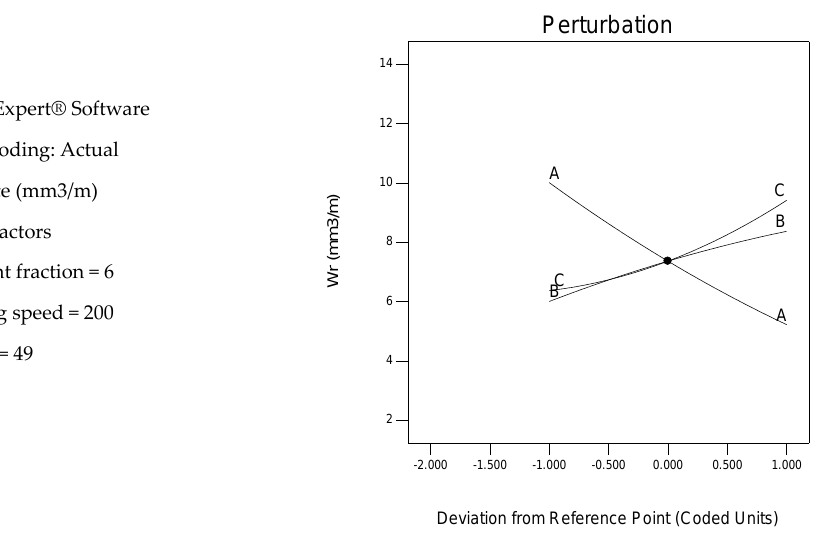
Figure 1. Experimental versus predicted wear rate mm 3 / m.